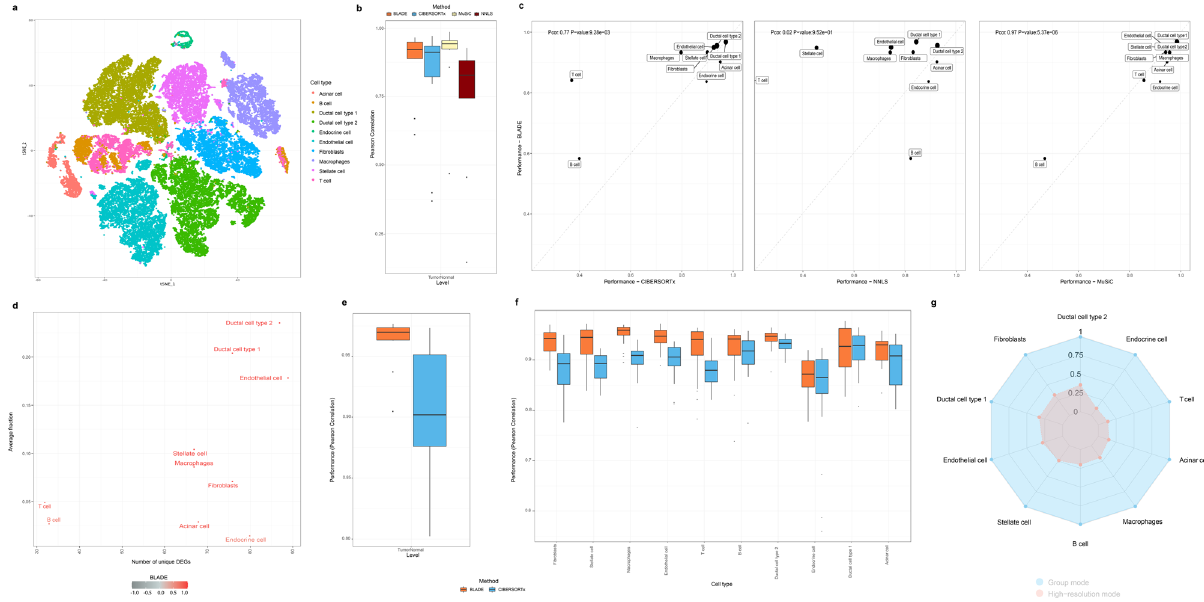
Fig. 7 Performance evaluation of BLADE for deconvoluting tumor data. a t-SNE plot showing the variability of the cell populations in the PDAC single-cell RNA-seq data. b Performances (Pearson correlation coef fi cient; y-axis) of BLADE (orange), CIBERSORTx (blue), NNLS (dark red), and MuSiC (light yellow) in predicting cellular fractions of the PDAC bulk RNA-seq data ( n = 29 main samples). The standard boxplot notation was used (lower/upper hinges — fi rst/third quartiles; whiskers extend from the hinges to the largest/lowest values no further than 1.5 * inter-quartile ranges). c Comparison of performance in estimating the cellular fractions of each cell type of BLADE ( y -axis) with CIBERSORTx (left), NNLS (middle), and MuSiC (right; x -axis). The fraction of each cell type is indicated by the point size. Pearson correlation coef fi cient and two-tailed test P -values are indicated at the top left in each panel. d The number of unique DEGs per cell type ( x -axis) and the respective fraction in the PDAC data ( y -axis). e Performance in Pearson correlation of BLADE (orange), CIBERSORTx (blue) for group mode puri fi cation ( n = 10 cell types). The standard boxplot notation was used. f Performance (Pearson correlation coef fi cient; y -axis) of BLADE (orange) and CIBERSORTx (blue) in estimating gene expression pro fi les per cell type ( x -axis) and per sample ( n = 29 samples for each cell type; right). The standard boxplot notation was used. g Fraction of genes in silico puri fi ed in group mode (blue) and high-resolution mode (blue) by